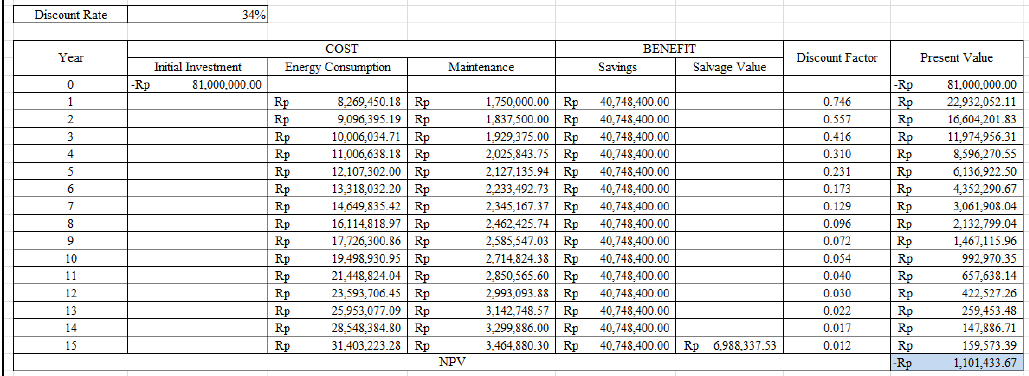
Figure 5. IRR calculation at 34%.